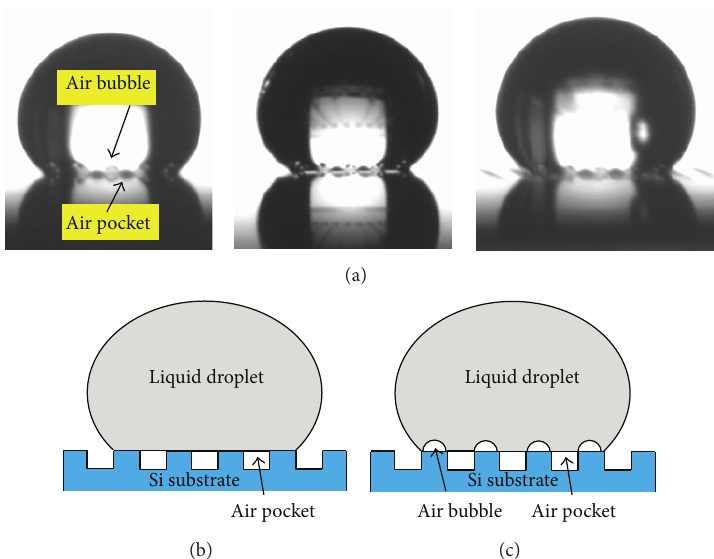
Figure 3: (a) Morphologies of water droplets on prepared grooved surfaces (120/120 𝜇 m) with height of 5 𝜇 m, 15 𝜇 m, and 50 𝜇 m, (b) schematic of the Cassie-Baxter model, and (c) reinforced Cassie-Baxter